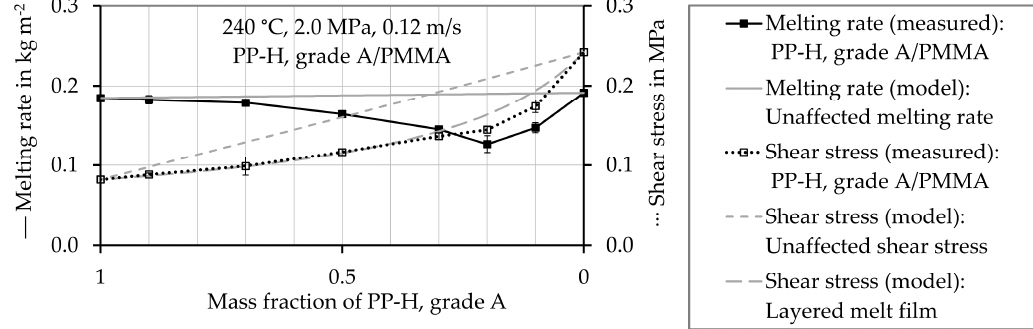
Figure 10. Measured and estimated values of the melting rate and shear stress of the mixture of PPH, grade A, and PMMA at a temperature of 240 °C.